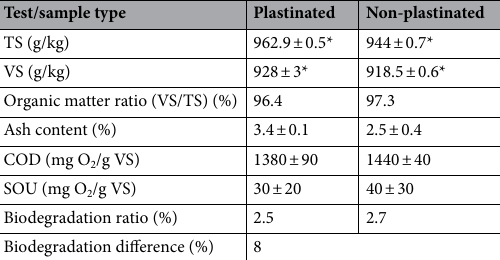
Table 3. Biodegradability test results. *Significance level, P -value < 0.05 (One-way